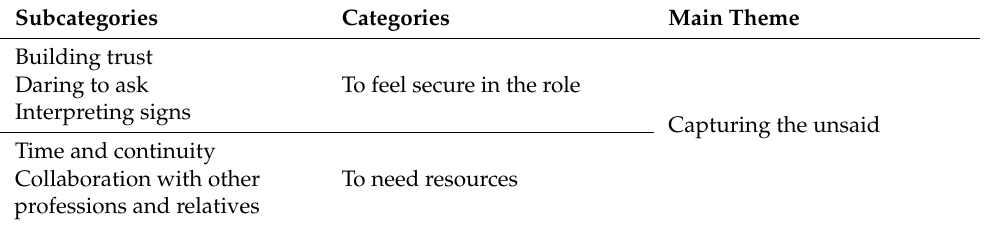
Table 4. Overview of the subcategories, categories, and main